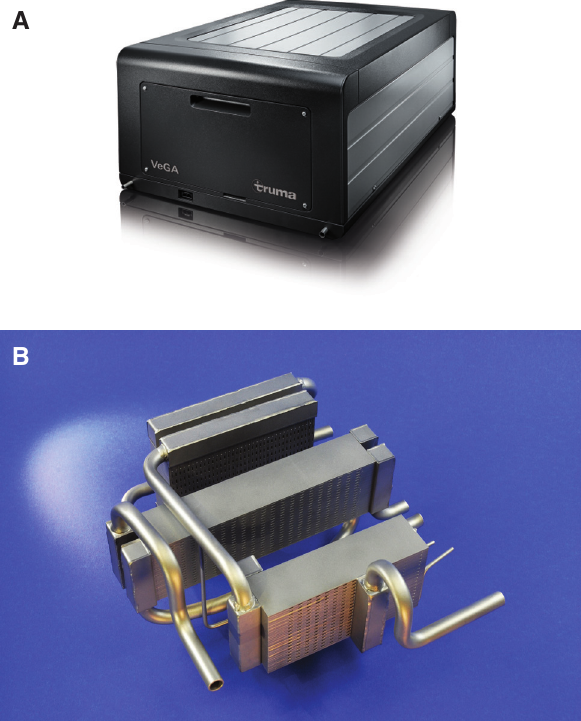
Figure 3 LPG based power supply (A) APU for recreational vehicles; (B) 250 W complete fuel